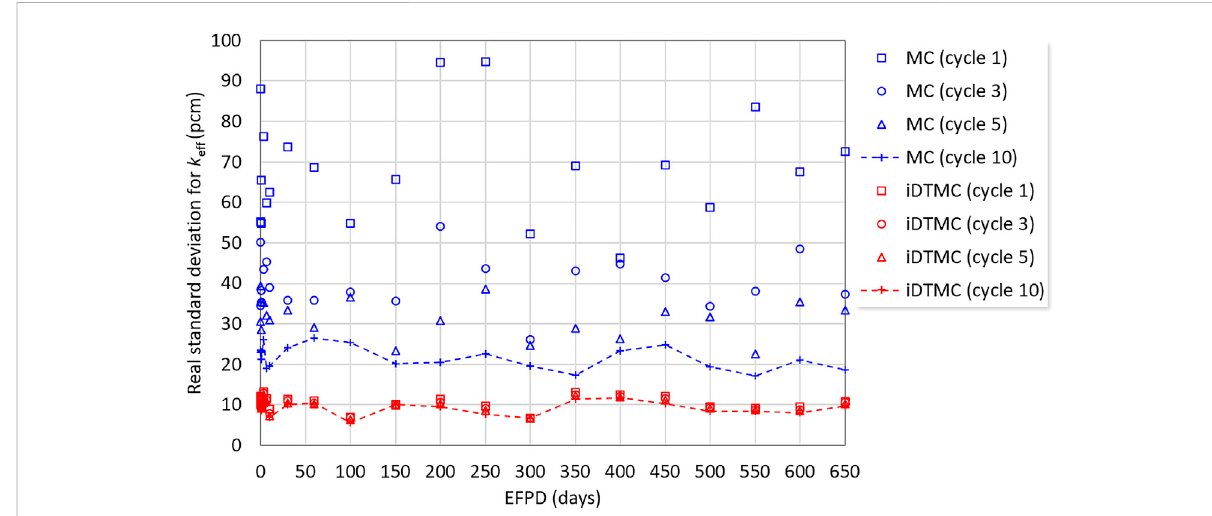
FIGURE 7 Real standard deviations for burnup dependent criticality at different active cycles.